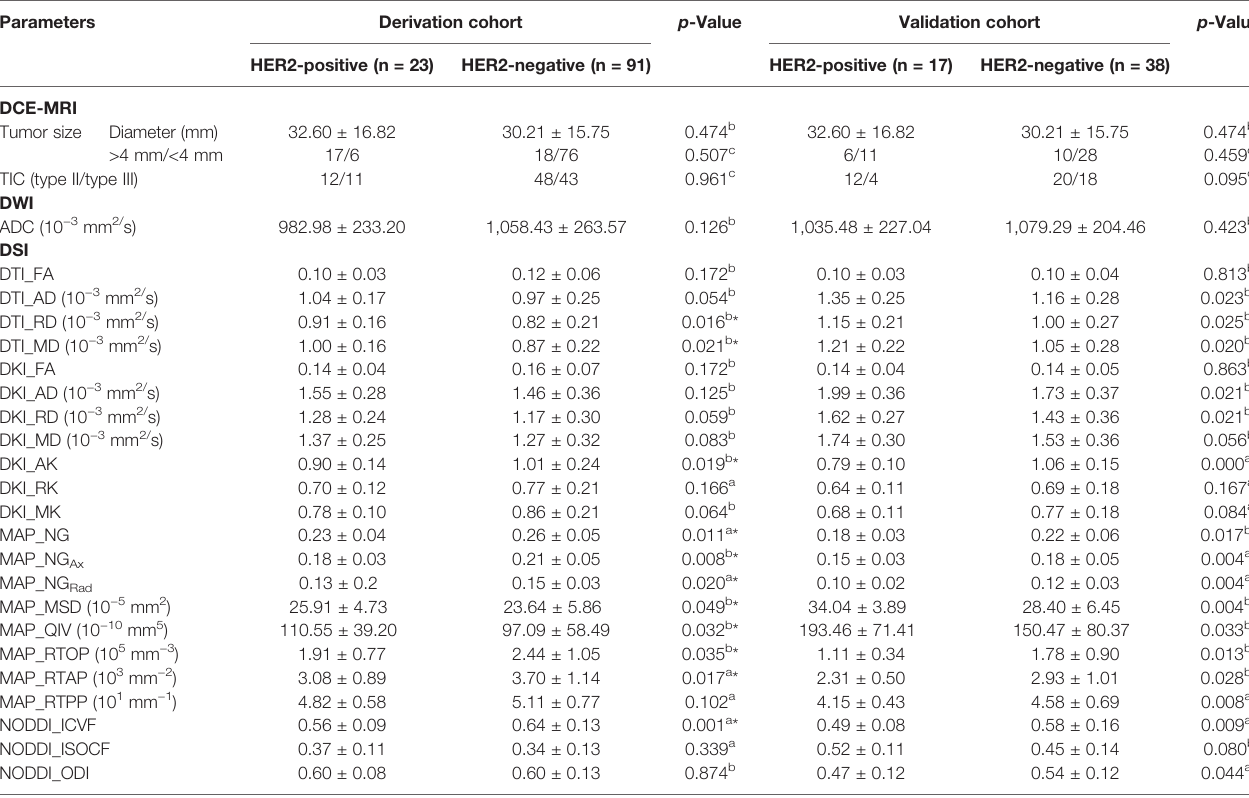
TABLE 3 | Comparisons of conventional MRI and quantitative DSI parameters between HER2-positive and HER2-negative